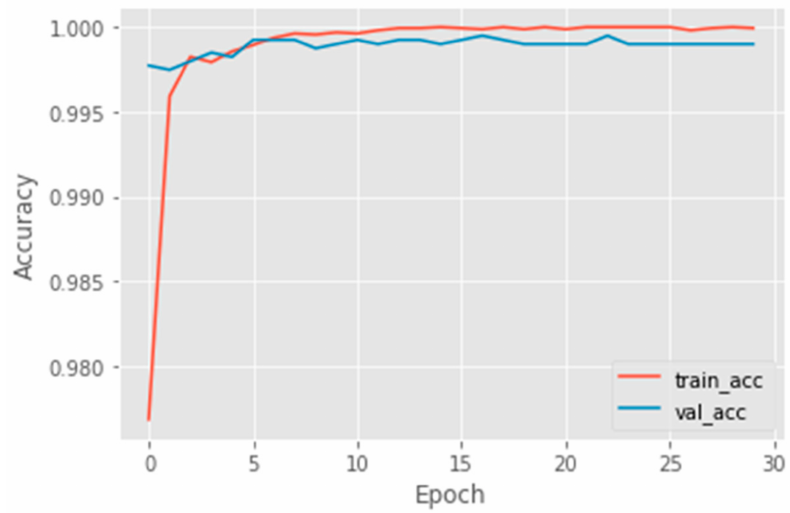
Figure 5. Training and validation